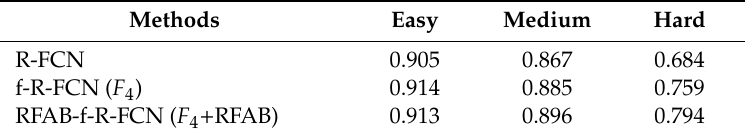
Table 4. AP comparison of different improvement schemes.